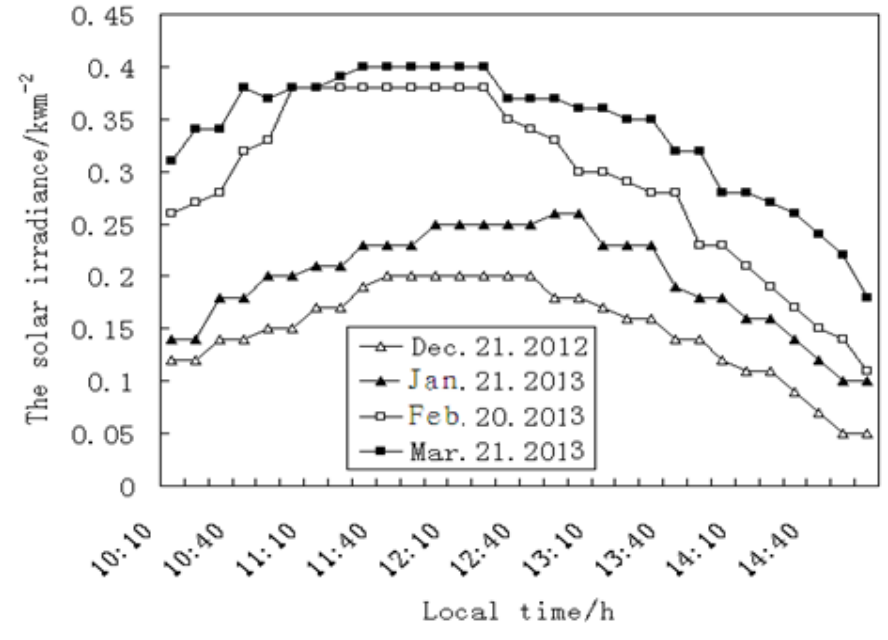
Figure 2. Amount of solar irradiance (kW/m 2 ) over time (plotted in 10-min increments) on sunny